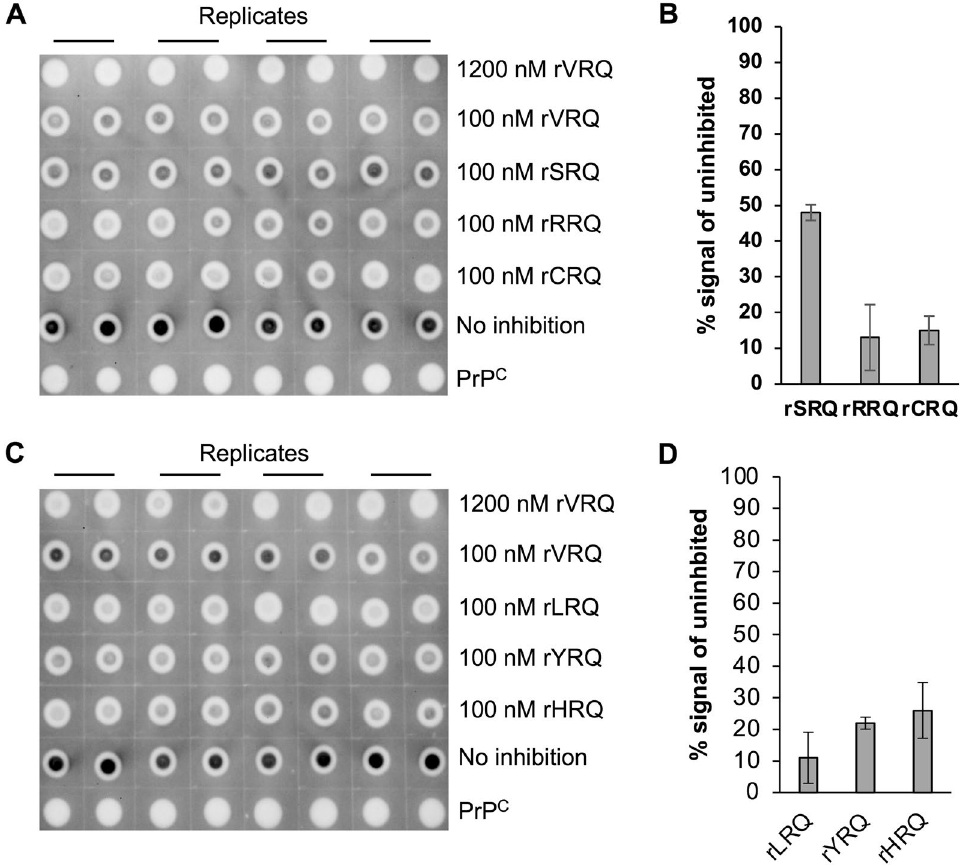
Figure 1. Inhibition of scrapie prion replication with 136 variants of rPrP. PMCA amplification of scrapie VRQ/ARQ prion in a VRQ/VRQ substrate was carried out in the absence or presence of a rPrP as indicated. Representative dot blot images are shown ( A , C ). Each sample was analysed in 8 replicate PMCA amplifications and 4 replicates were analysed (in duplicate) on each of two dot blots. Dot blots were analysed by densitometry and the PrP Sc signals for each duplicate analysis were averaged. Then the signal above the blot background (1200 nM rVRQ inhibition) for each sample were expressed as a percentage of the signal for the no inhibition control (examples are shown in ( B , D ). Averages of the 8 PMCA replicates were used and SD is shown ( B , D ). PrP C (brain PMCA substrate) was used as a PK-digestion control, inhibition with 100 nM rVRQ was also carried out in each experiment as a known inhibitor control.